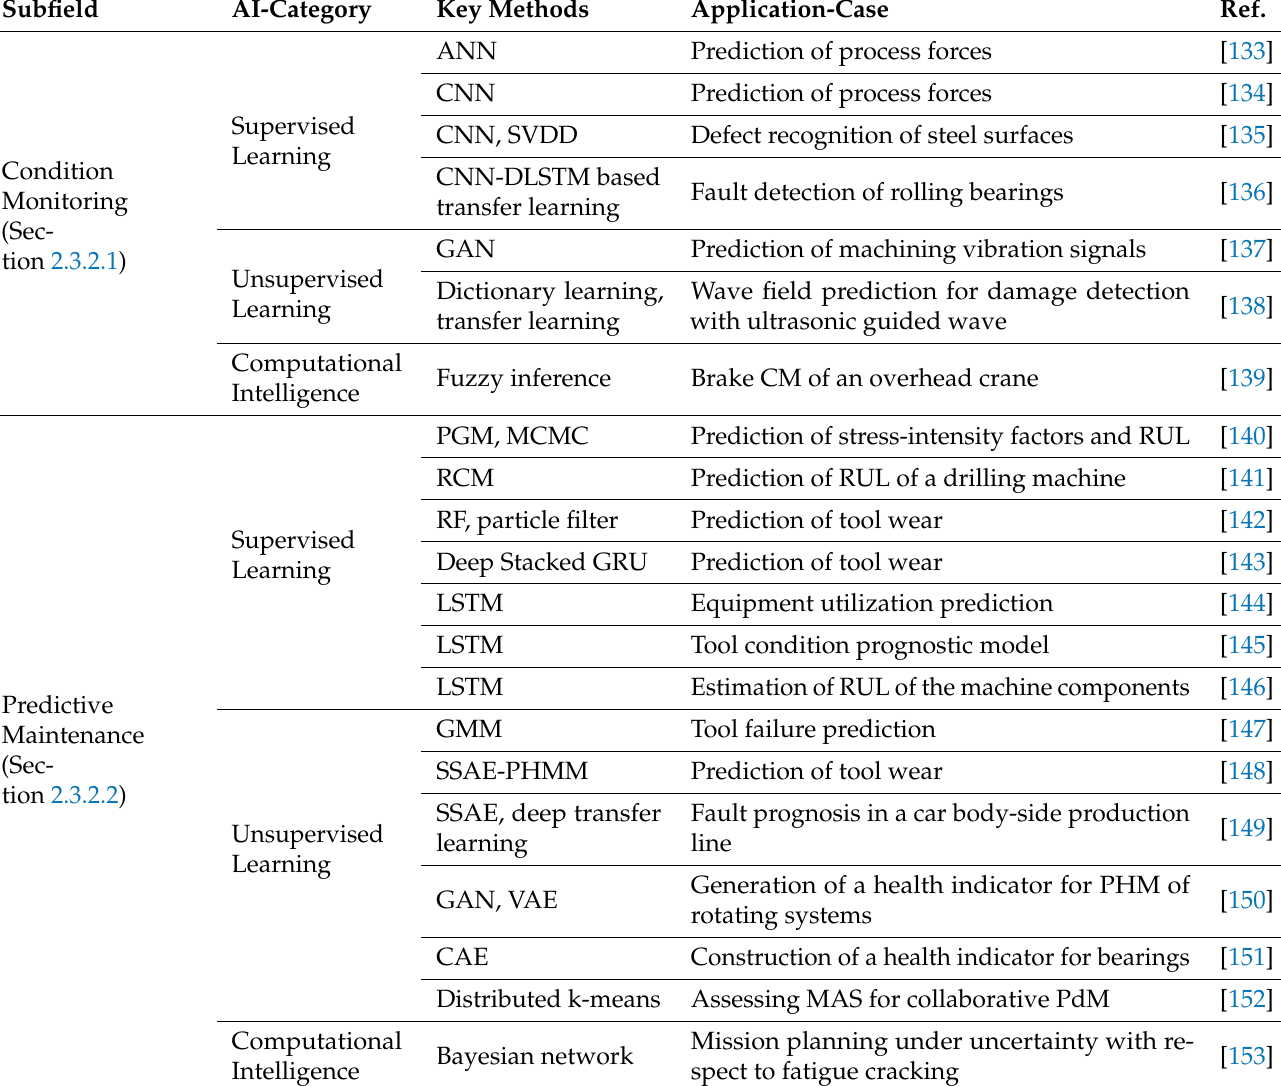
Table 2. Summary of AI-enabled DTs in smart manufacturing: machinery and equipment level (Section 2.3). Subfield AI-Category Key Methods Application-Case